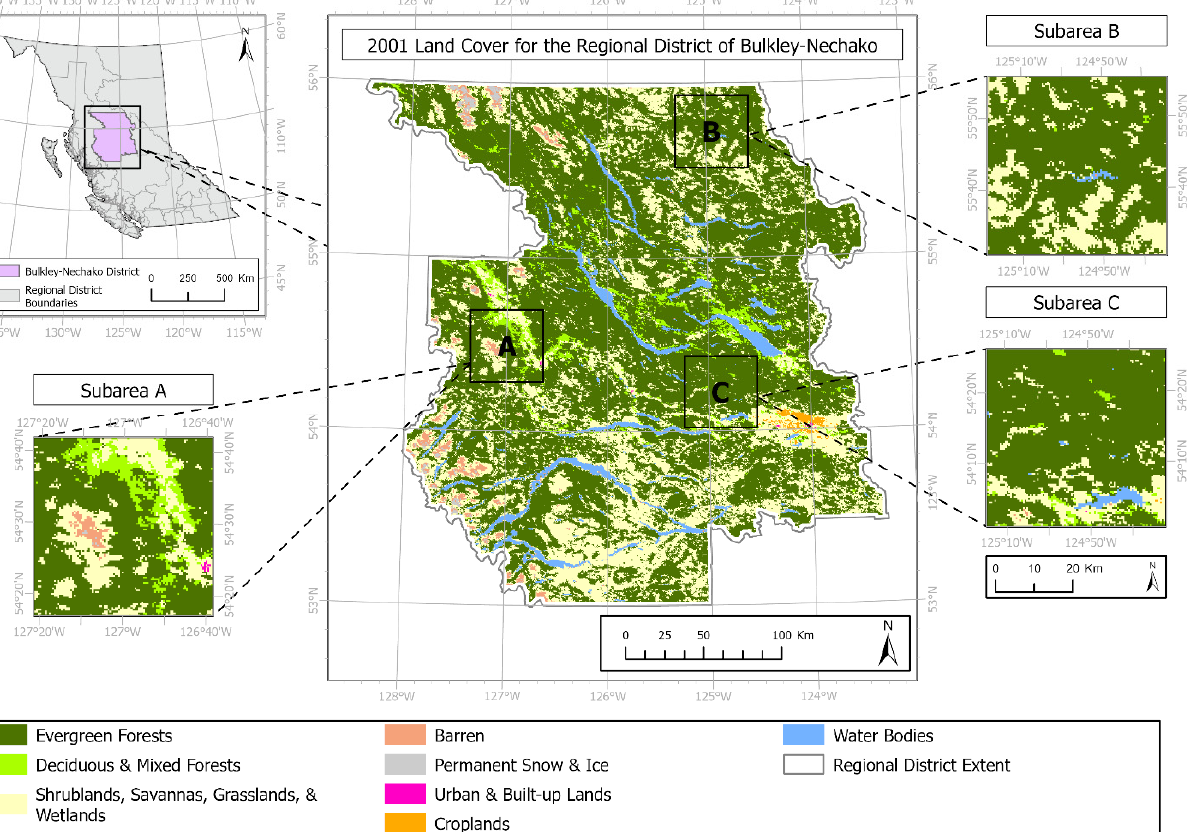
Figure 1. 2001 land cover of the primary study area of the Regional District of Bulkley-Nechako, BC. Data are displayed with the NAD 1983 BC Environment Albers projected coordinate system. Subareas A, B, and C are subsets of the Regional District of Bulkley-Nechako involved in exploring and identifying preliminary experimental trends in subsequent sections. Table 1. Area covered by each land cover class in 2001 and 2019 for (R1) the Regional District of Bulkley-Nechako, (R2) the Regional District of Central Kootenay, (R3) the Northern Rockies Re- gional Municipality, and (R4) the Cariboo Regional District.